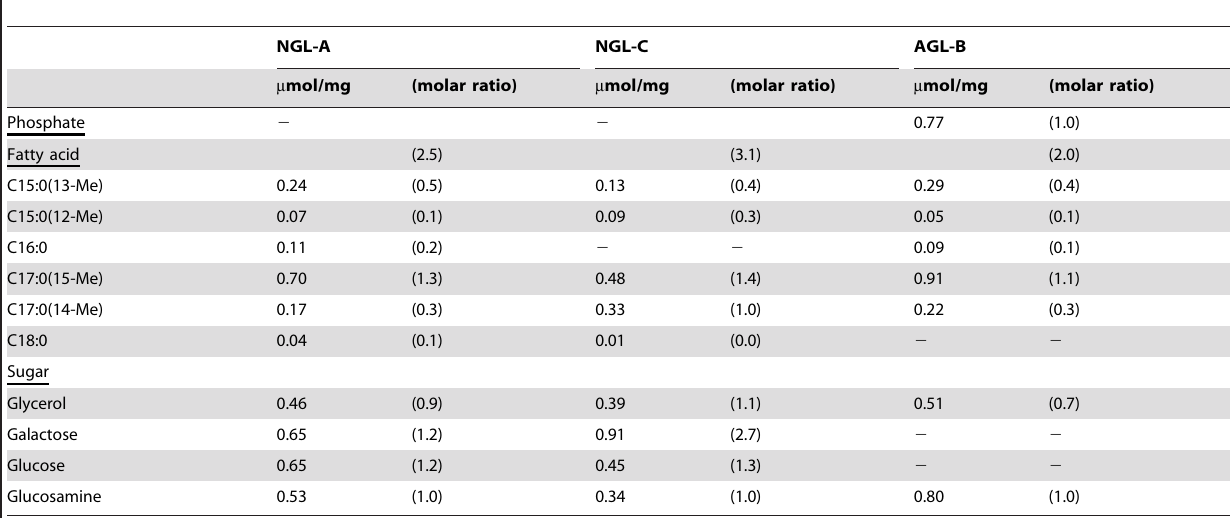
Table 2. Chemical Composition of neutral and acidic glycolipids extracted from T. thermophilus